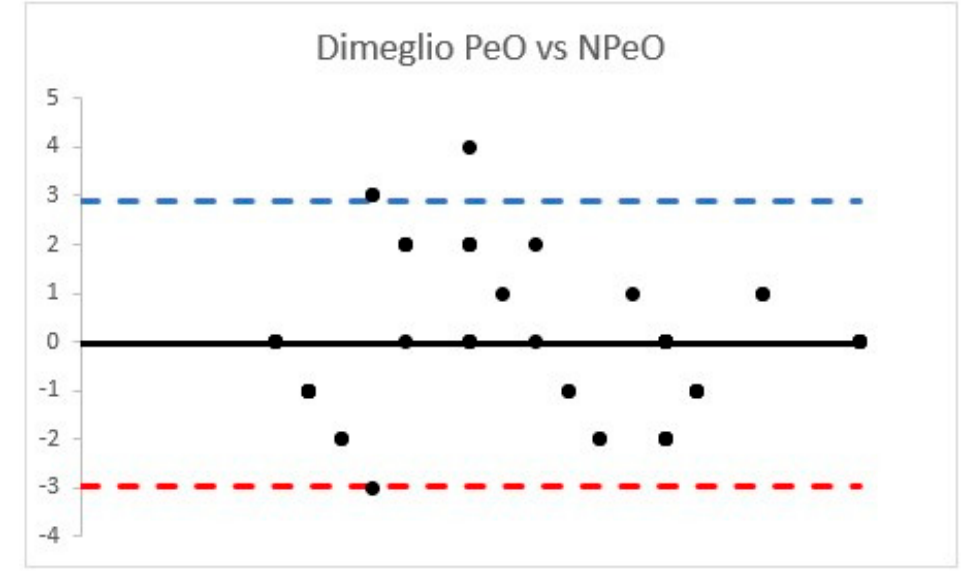
Figure 4. Bland Altman plots according to OS and RS Dimeglio score.